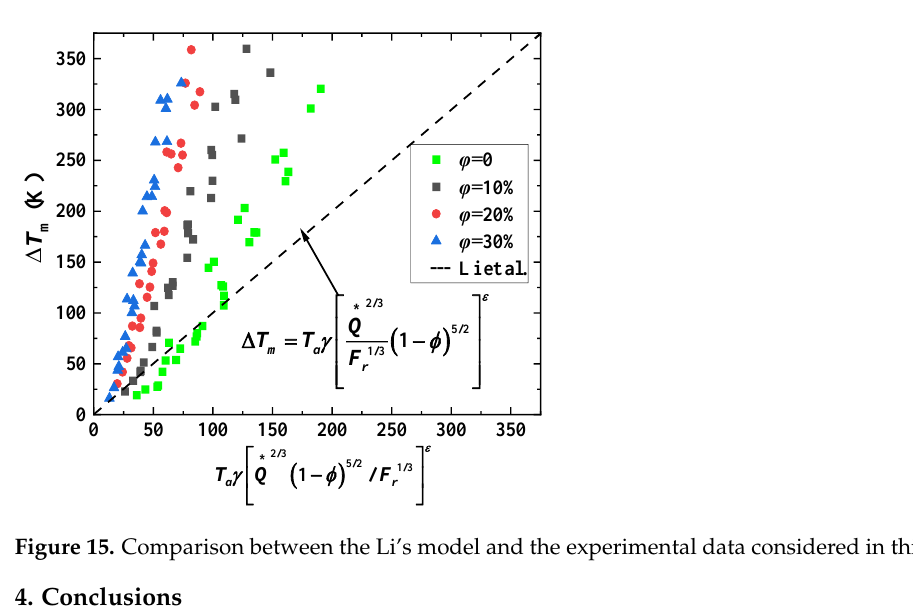
Figure 14. Maximum temperature rise prediction formula of different blockage ratios.